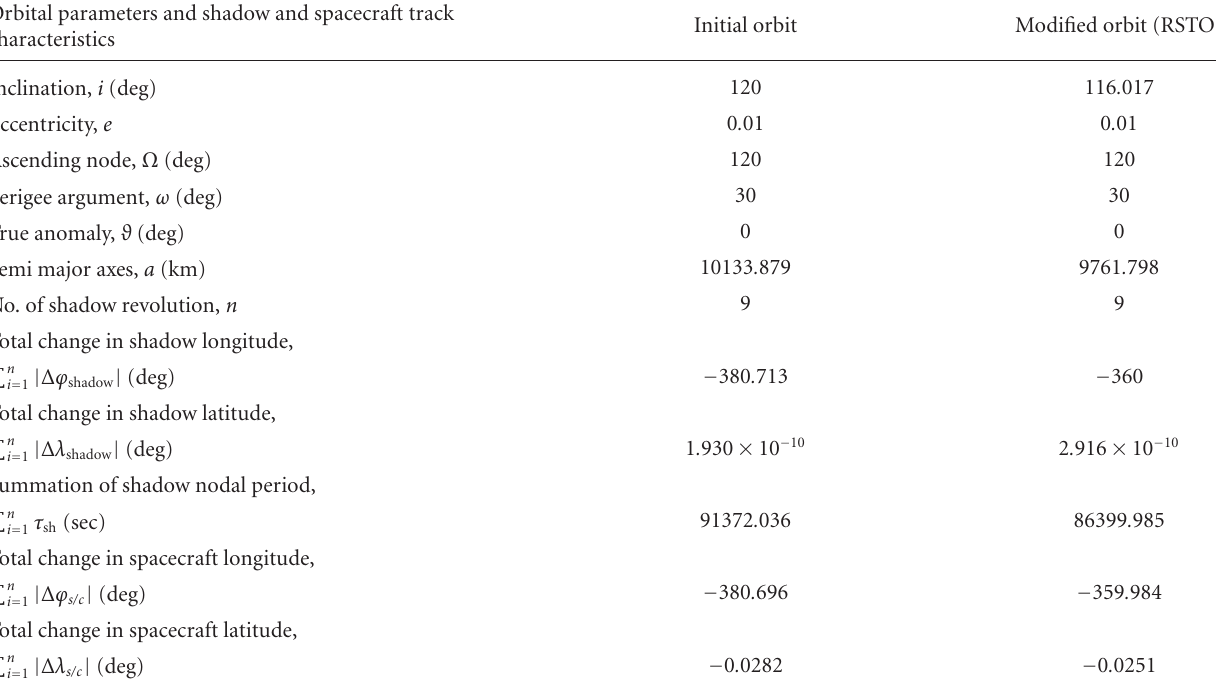
Table 2: The initial and modified orbital elements and their shadow and spacecraft track characteristics. Orbital parameters and shadow and spacecraft track